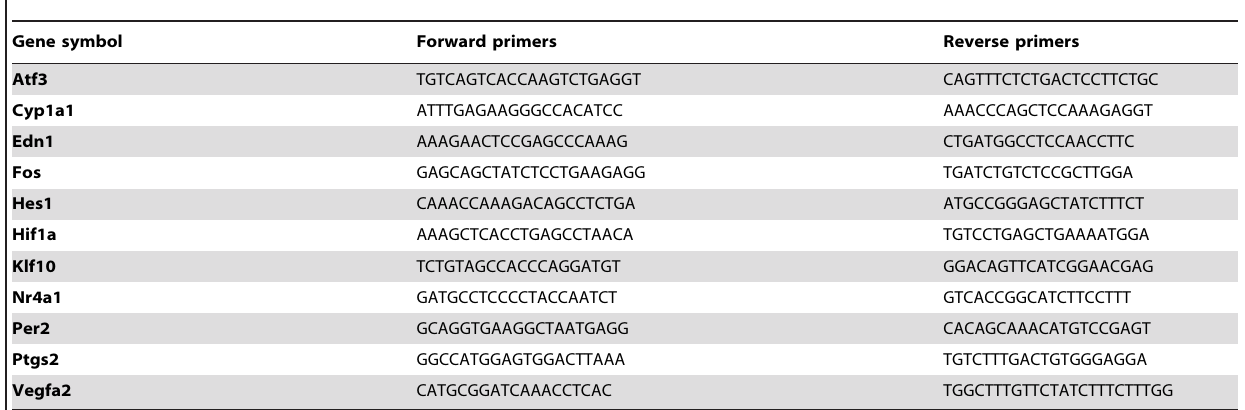
Table 5. Primer sequences for